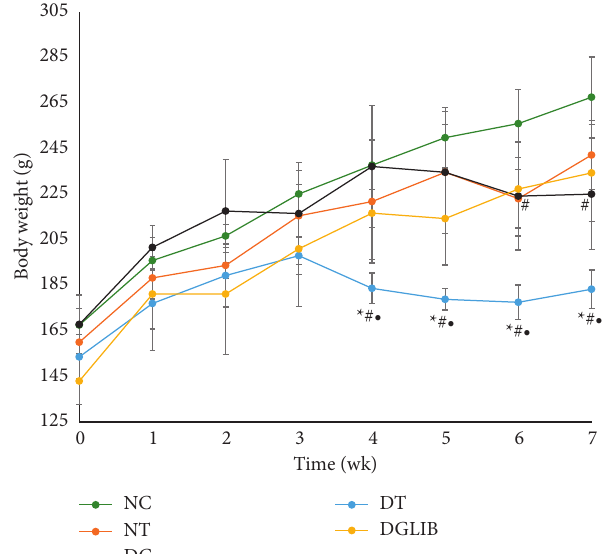
Figure 4: The effect of the cocktail on the body weight of the animals over the period of the study. Data are expressed as mean ± standard error of the mean and analysed by Tukey post hoc statistical test. NC: normal control, NT: normal treatment, DC: diabetic control, DT: diabetic treatment, and DGlib: diabetic glibenclamide group, where # indicates p ≤ 0 . 05 when compared with NC. ∗ indicates p ≤ 0 . 05 when compared with DGLIB. • indicates p ≤ 0 . 05 when compared with DC; significant difference is considered at p ≤ 0 .